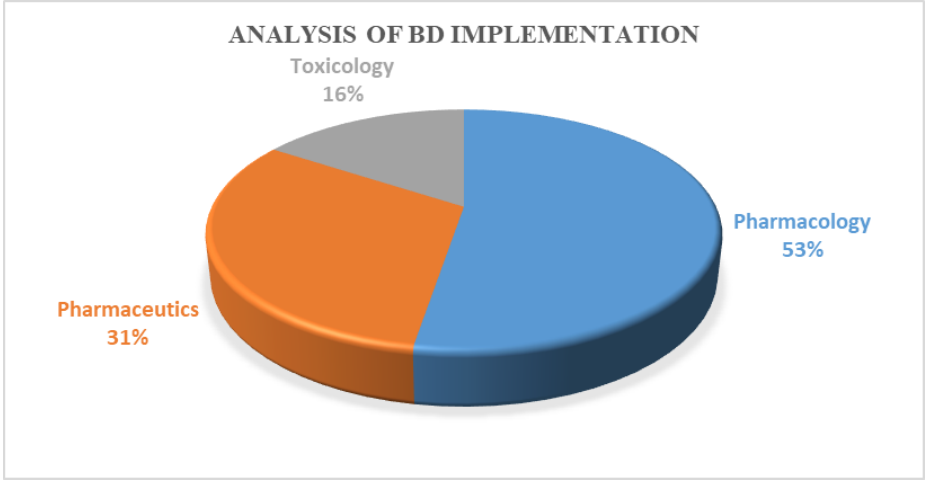
Figure 5. Analysis of BD implementation in Pharmacology, Toxicology and